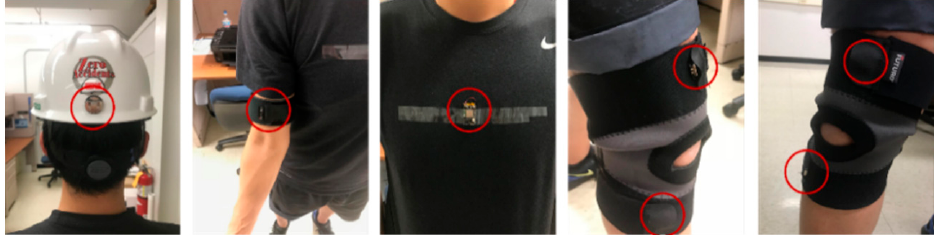
Figure 2. Sensor placement (head, right arm, chest, right thigh, and calf) in lab test [5].